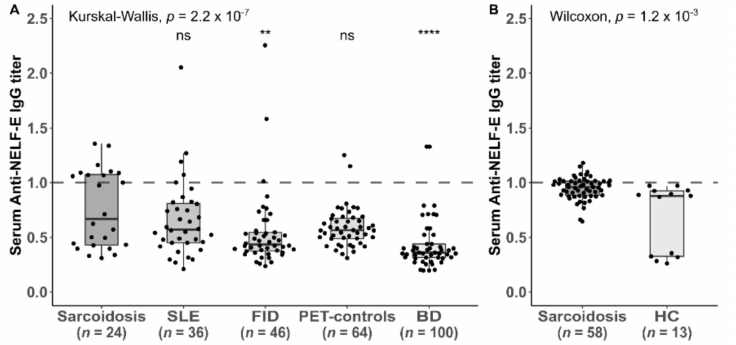
Figure 3. Titers of IgG-antibodies against the Negative Elongation Factor E across di ff erent diseases in two di ff erent cohorts: ( A ) initial derivation cohort including patients with sarcoidosis, systemic lupus erythematosus (SLE), febrile infectious disease (FID), patients with miscellaneous diseases within the positron emission tomography (PET)-controls and blood donors (BD); ( B ) validation cohort including patients with sarcoidosis ( n = 58) and healthy controls (HC) ( n = 13). The titer is considered positive, if it is the same or higher than the cut-o ff serum (dashed line. Global Kruskal-Wallis is shown, as well as pairwise Wilcoxon-tests of disease groups vs. the sarcoidosis group (**** indicates p < 0.0001; ** indicates p < 0.01, ns indicates p ≥ 0.05).